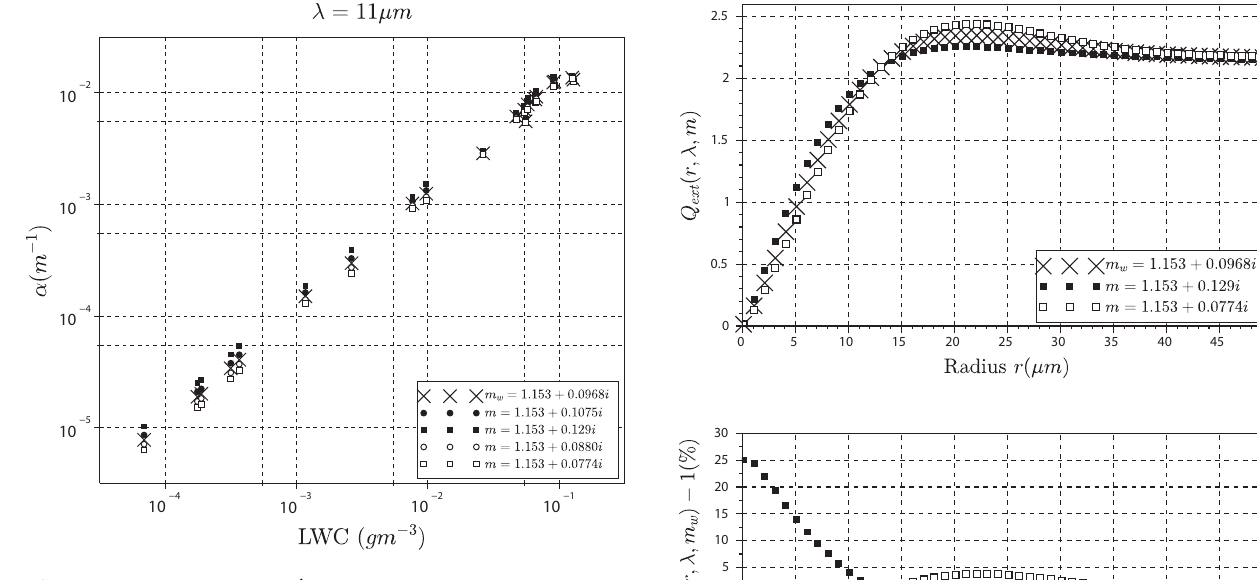
Fig. 9. Extinction coefficients (as a function of the liquid water con- tent) for the 20 size distributions of PARISFOG for a refractive in- dex with a variable imaginary part. The reference is the refractive index of water m w = 1 . 153 + 0 . 0968 i(x) . The circles and squares are for the refractive indices that produce maximum extinction ef- ficiency relative errors of 10% and 25% respectively, in excess (filled) or default (open).